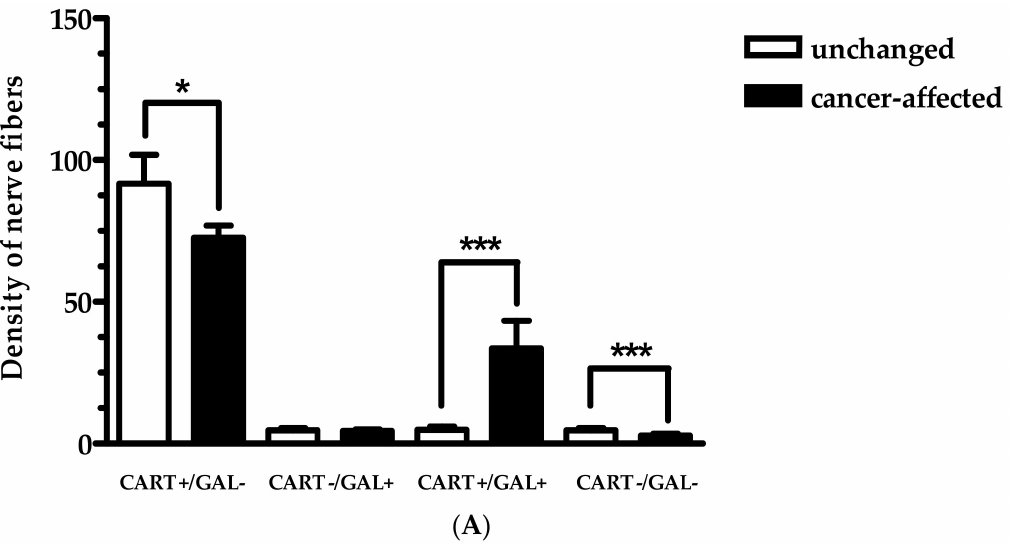
Figure 4. Micrographs showing nerve fibers triple immunostained for cocaine- and amphetamine-regulated transcript (CART), galanin (GAL), and protein-gene product 9.5 (PGP 9.5; as a pan-neuronal marker). Micrographs ( A – F ) showing the superposition of all three channels simultaneously: red—CART, green—GAL, and blue—PGP 9.5. Distribution pattern of nerve fibers immunoreactive for studied substances within the longitudinal (LML), circular (CML), and lamina muscularis mucosae (LMM) in the human stomach wall affected by cancer (Figure 4D–F, respectively) and control tissue derived from the operative margin (Figure 4A–C, respectively). Scale bar = 100 µ